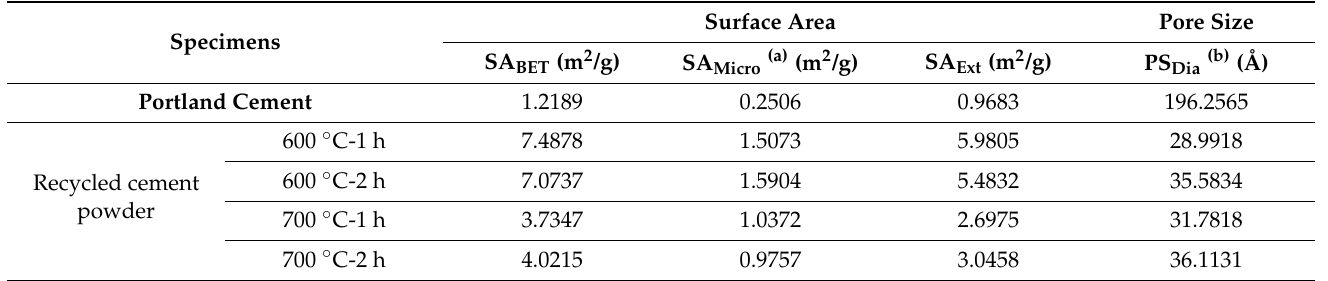
Table 4. Summary of results from N 2 gas adsorption